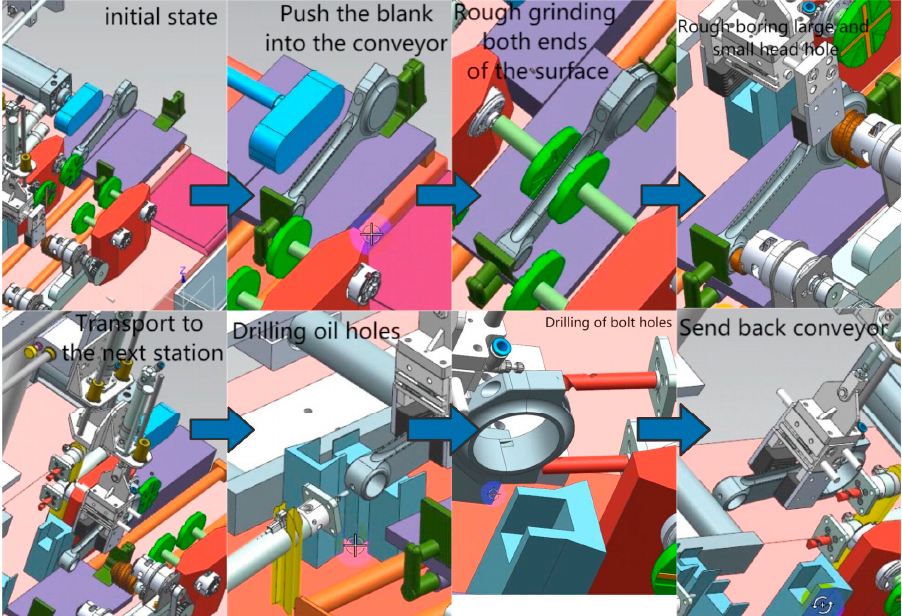
Figure 8. Simulation sequence of the model of the first part of the processing area.